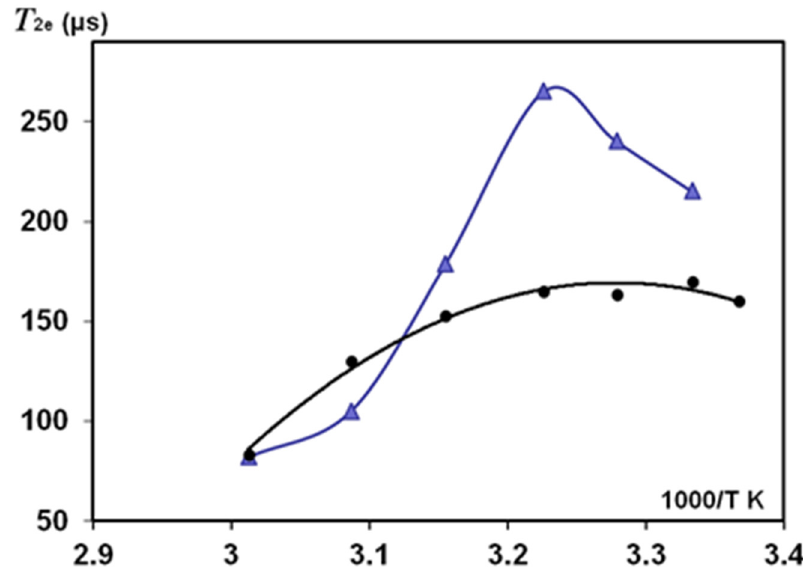
Figure 8. Temperature dependence of the apparent spin-spin relaxation time of slow-relaxing com- ponent of water protons ( T 2e ) in two silk fibres B. mori samples (originally HL = 0.083); the samples were slowly heated in the NMR coil and measured after each 5–7 ◦ increase in temperature. Solid lines provide guidance for the eye. (1) (Blue triangles) silk fibres with 90 ◦ orientation. (2) (Black circles) silk fibres with 0 ◦